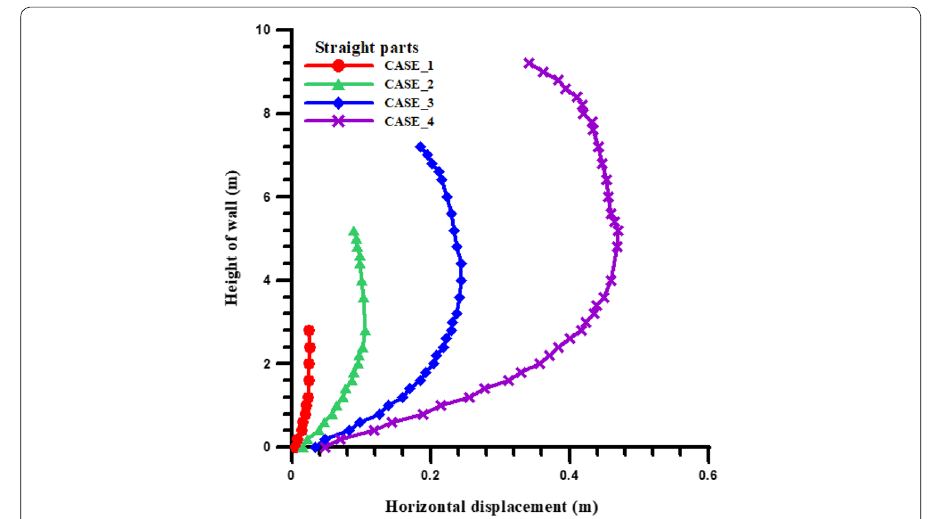
Fig. 9 Horizontal displacements for straight parts